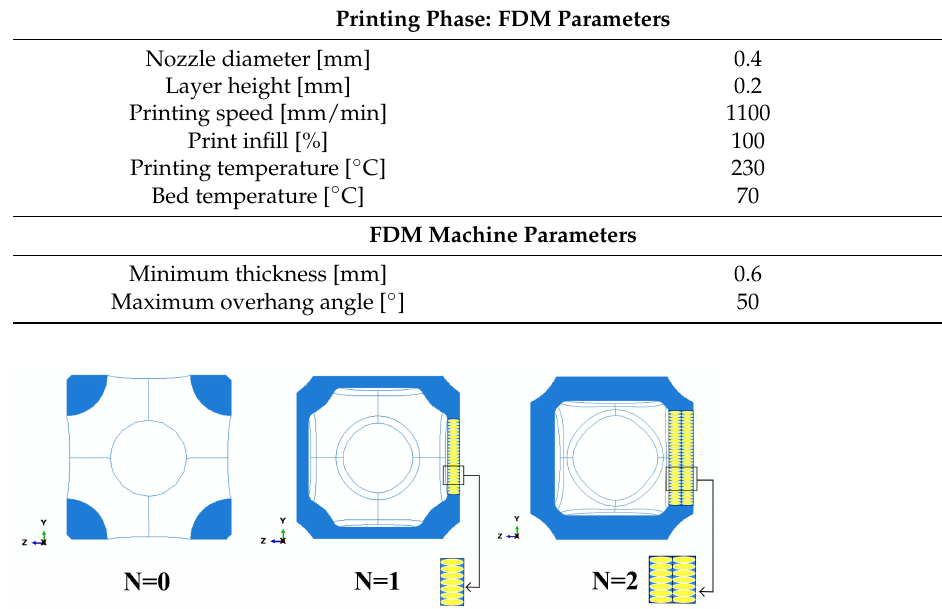
Table 1. Printing process parameters.